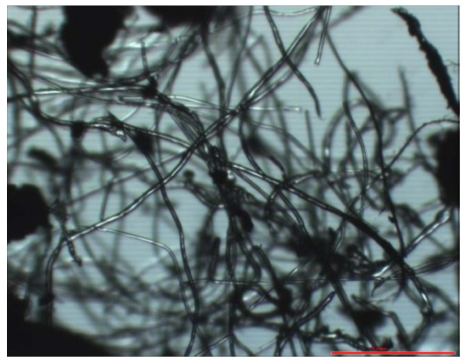
Figure 2. Fibers with optical microscopy.